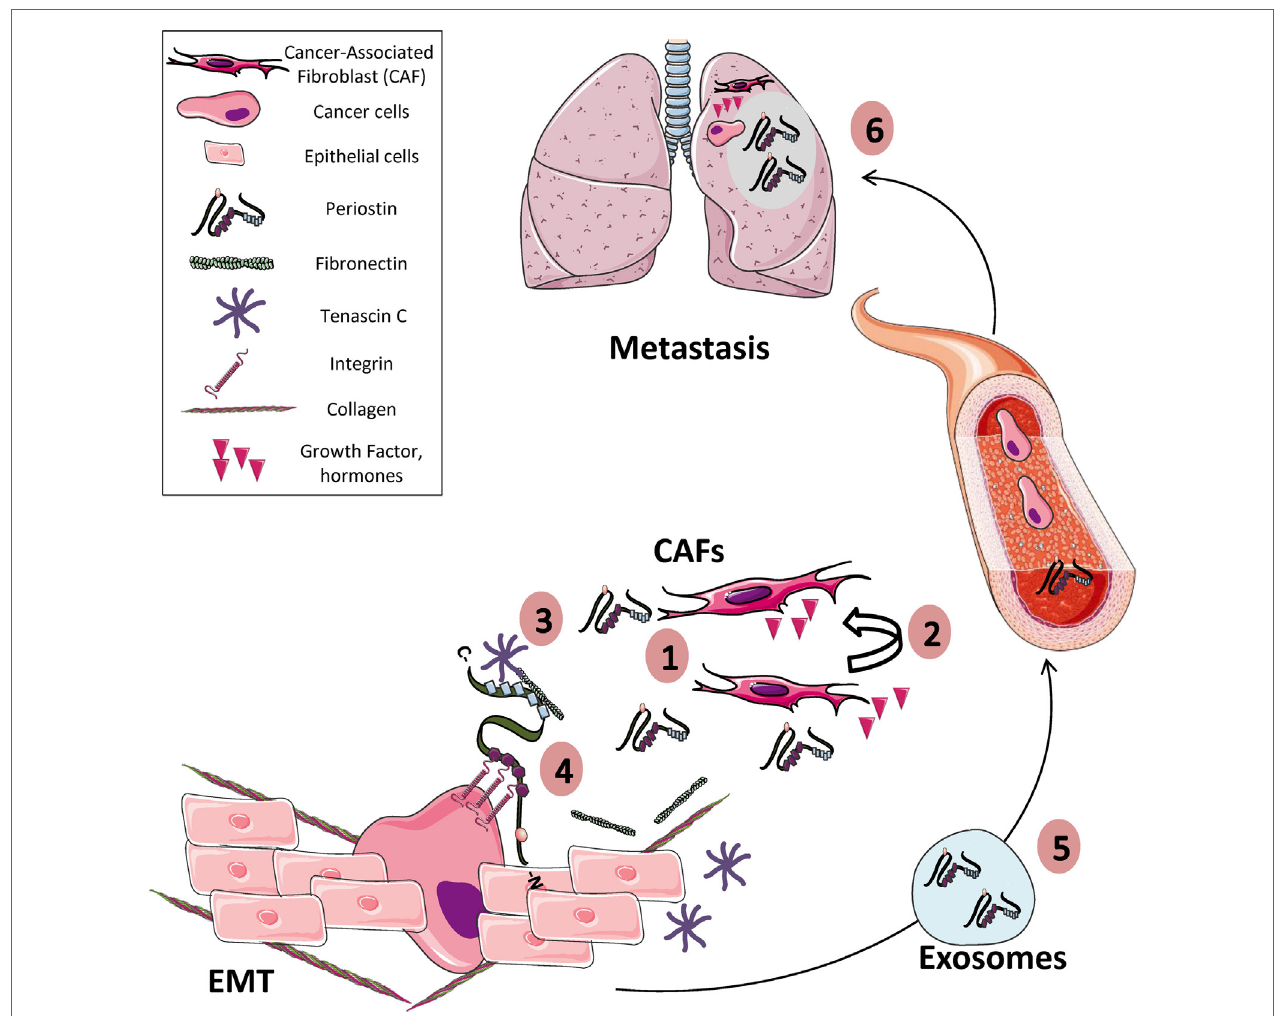
FiGURe 1 | Periostin (POSTN) and the hallmarks of cancer. (1) POSTN is overexpressed in many solid tumors, mainly by stromal cells such as cancer-associated fibroblasts and to a lesser extent by tumor cells themselves. (2) Both paracrine and autocrine signals can stimulate the expression of POSTN by stromal and tumor cells. (3) Extracellularly secreted POSTN interacts with others extracellular matrix (ECM) proteins (e.g., collagens, tenascin C, fibronectin) contributing to produce a tumor-receptive ECM, by modulating, for example, collagen cross-linking. (4) In addition, POSTN interacts with integrin receptors present in the membrane of cancer cells, promoting cell proliferation, cell survival, epithelial–mesenchymal transition (EMT), and migration. (5) POSTN can be transported into exosomes produced from stromal and tumor cells to distant sites in other tissues (e.g., lung, liver, or bone) or produced by CAFs (6) where it contributes to prepare the metastatic niche before the arrival of tumor